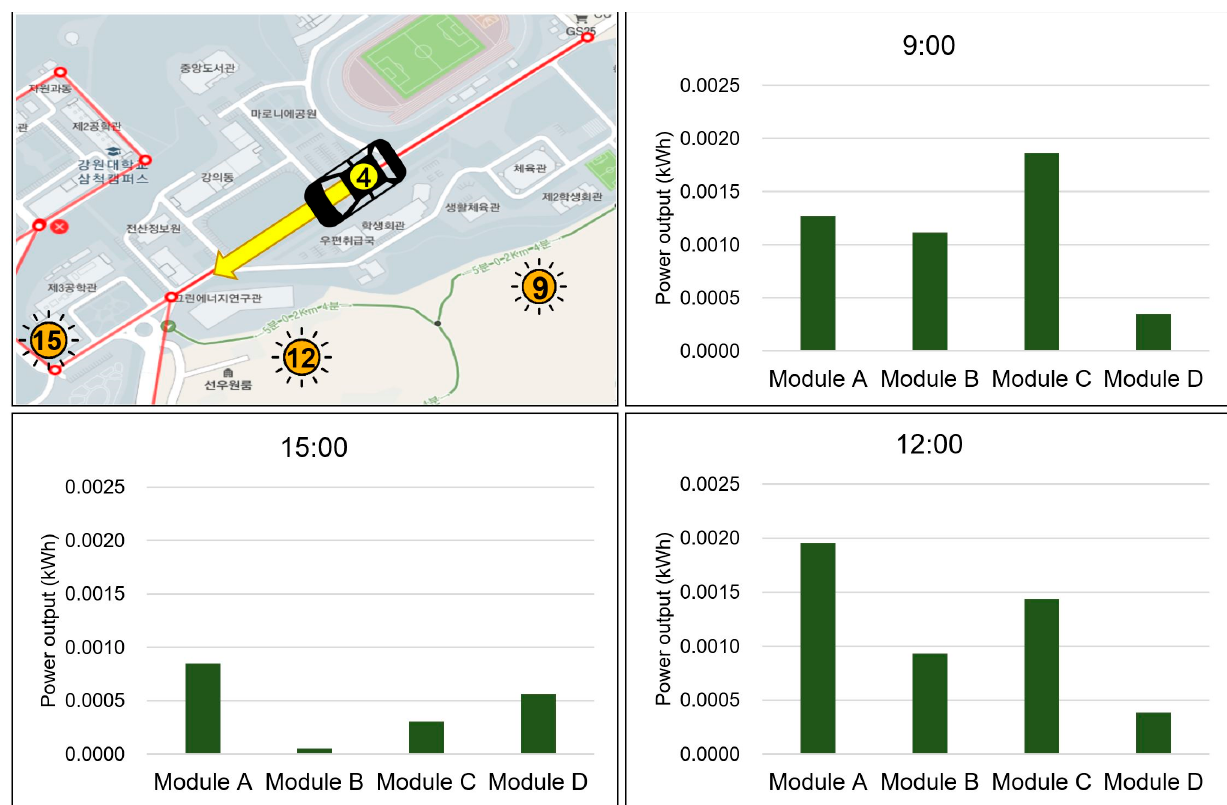
Figure 8. Comparison of PV potentials of four modules at different time in section 4 (Korean labels in the map indicate the building name).